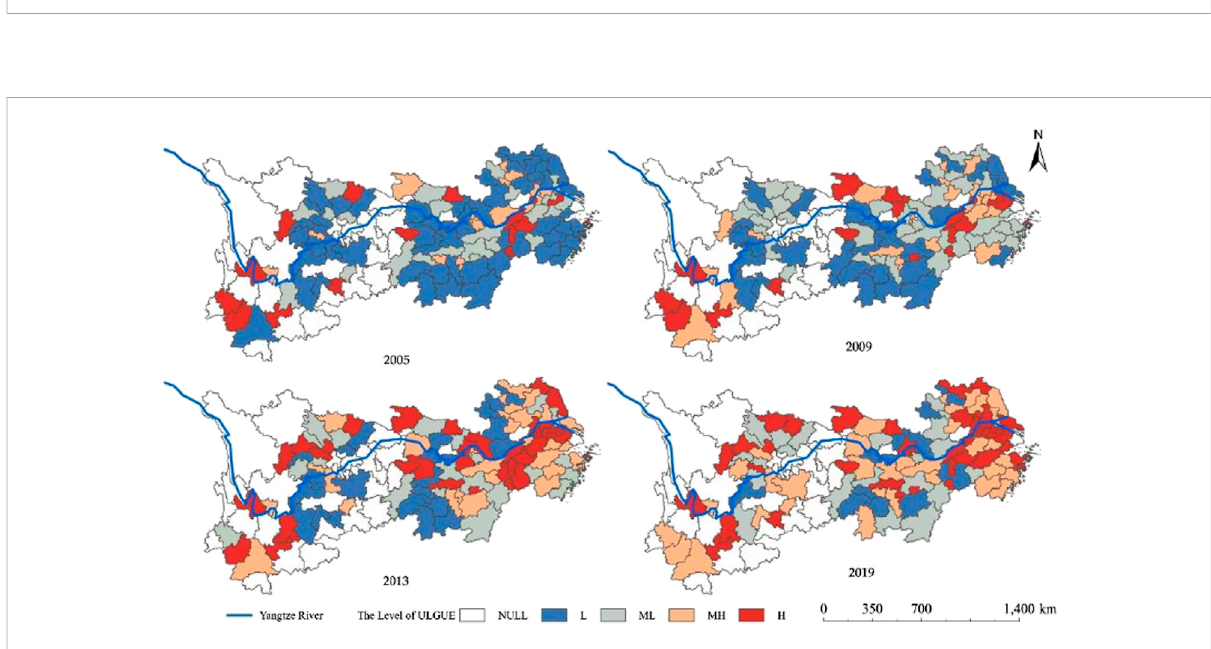
FIGURE 4 Spatial distribution pattern of ULGUE in the Yangtze River Economic